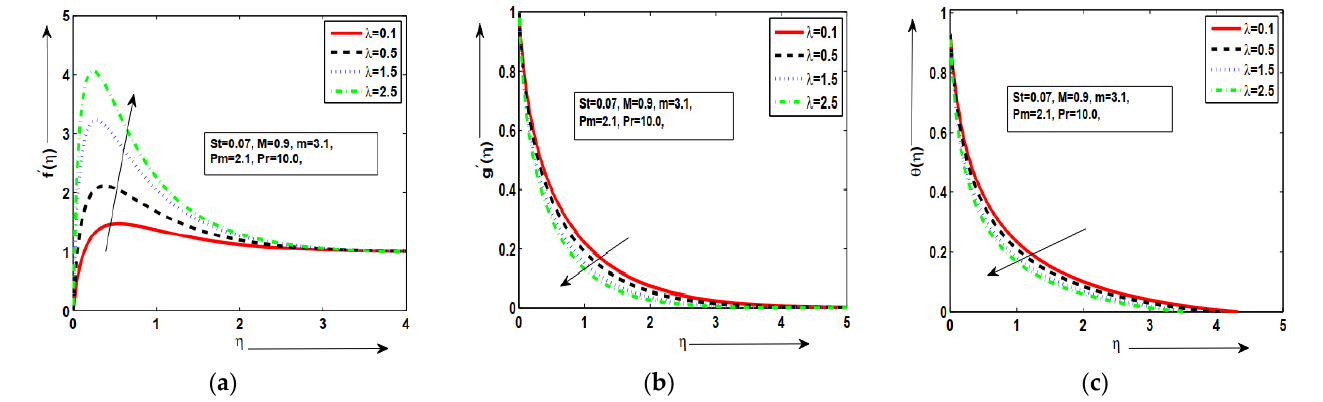
Figure 3. ( a – c ) The geometric profiles of